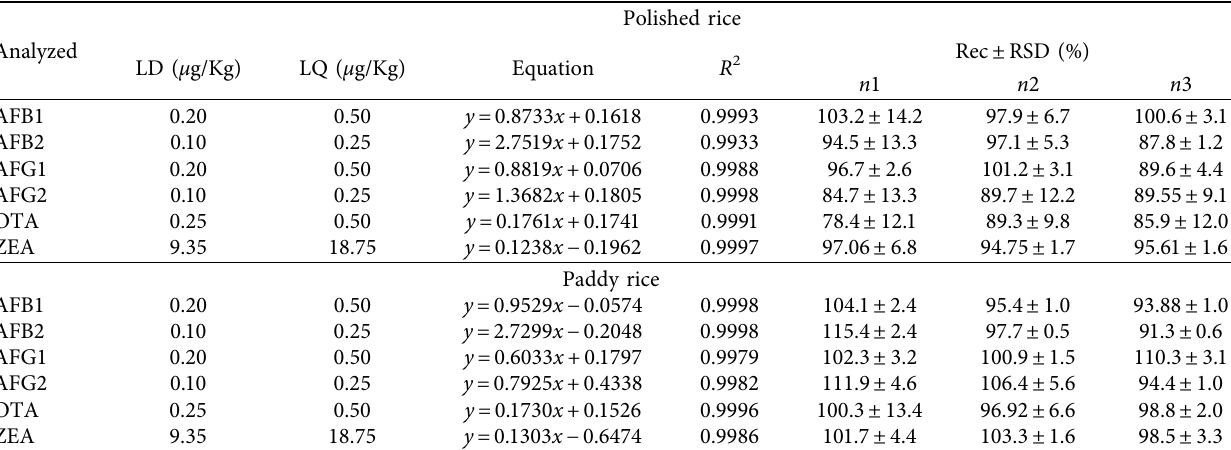
Figure 1: Characteristic chromatogram obtained for the separation of (a) AFG2, AFG1, AFB2, AFB1, and OTA in a standard mix of concentrations of 5.0 µ g/Kg for AFG1 and AFB1, 2.5 µ g/Kg for AFG2 and AFB2, and 5.0 µ g/Kg for OTA (b) standard solution of ZEA at a concentration of 200.0 µ Table 1: Results for validation, sensitivity (limit of detection (LD) and quantification(LQ)), linearity (determination coefficients: R 2 , x : concentration, y : signal), and interday precision ( n � 9, RSD: relative standard deviation) studied at three concentration levels.